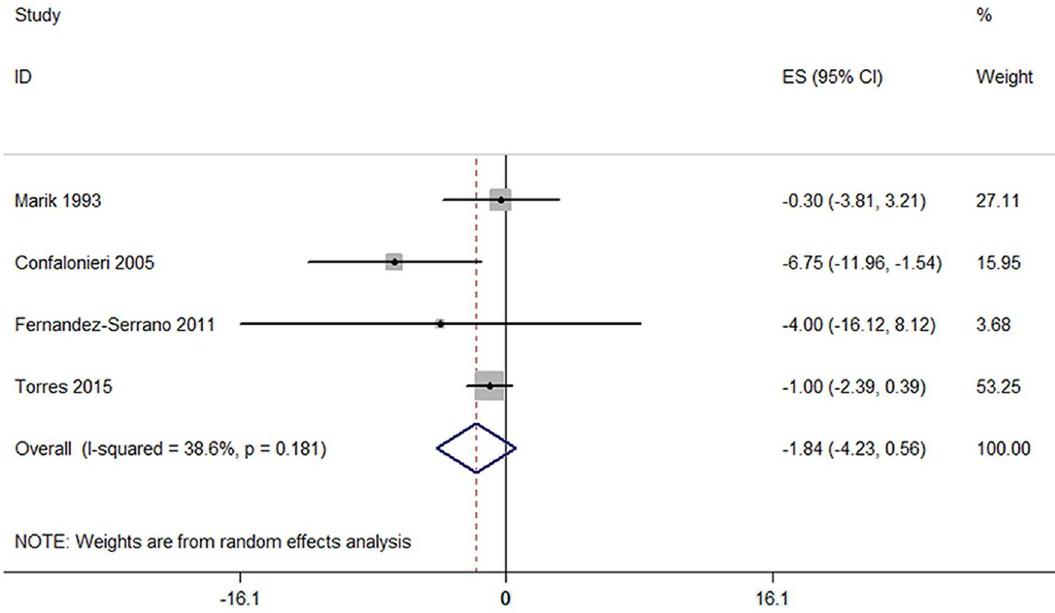
Fig 5. Forest plots of the association between length of ICU stay and corticosteroids.